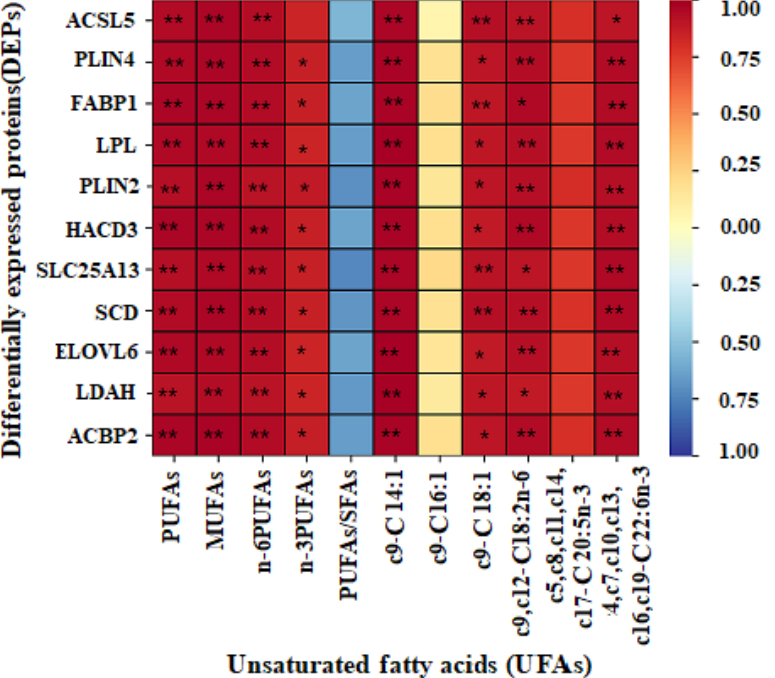
Figure 3. The Pearson correlation of UFAs absolute content, PUFAs/SFAs with the abundance of important proteins in yak subcutaneous fat. Color represents the Pearson’s correlation coefficient.